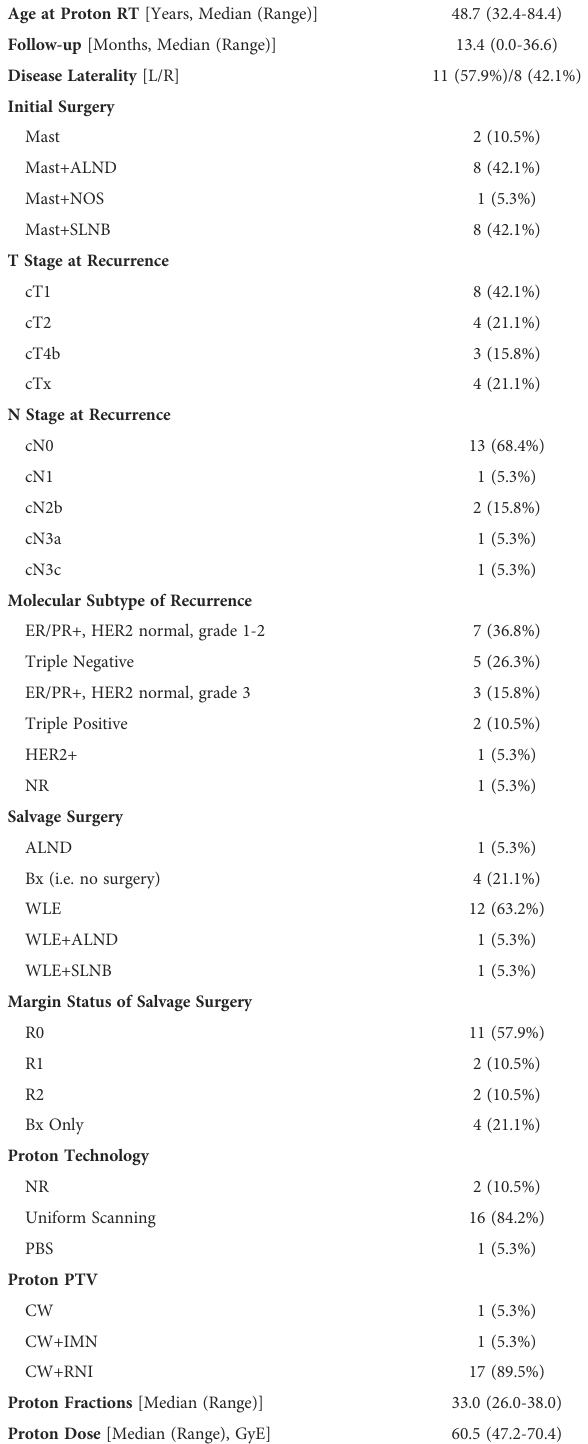
TABLE 1 Patient and treatment characteristics (N =